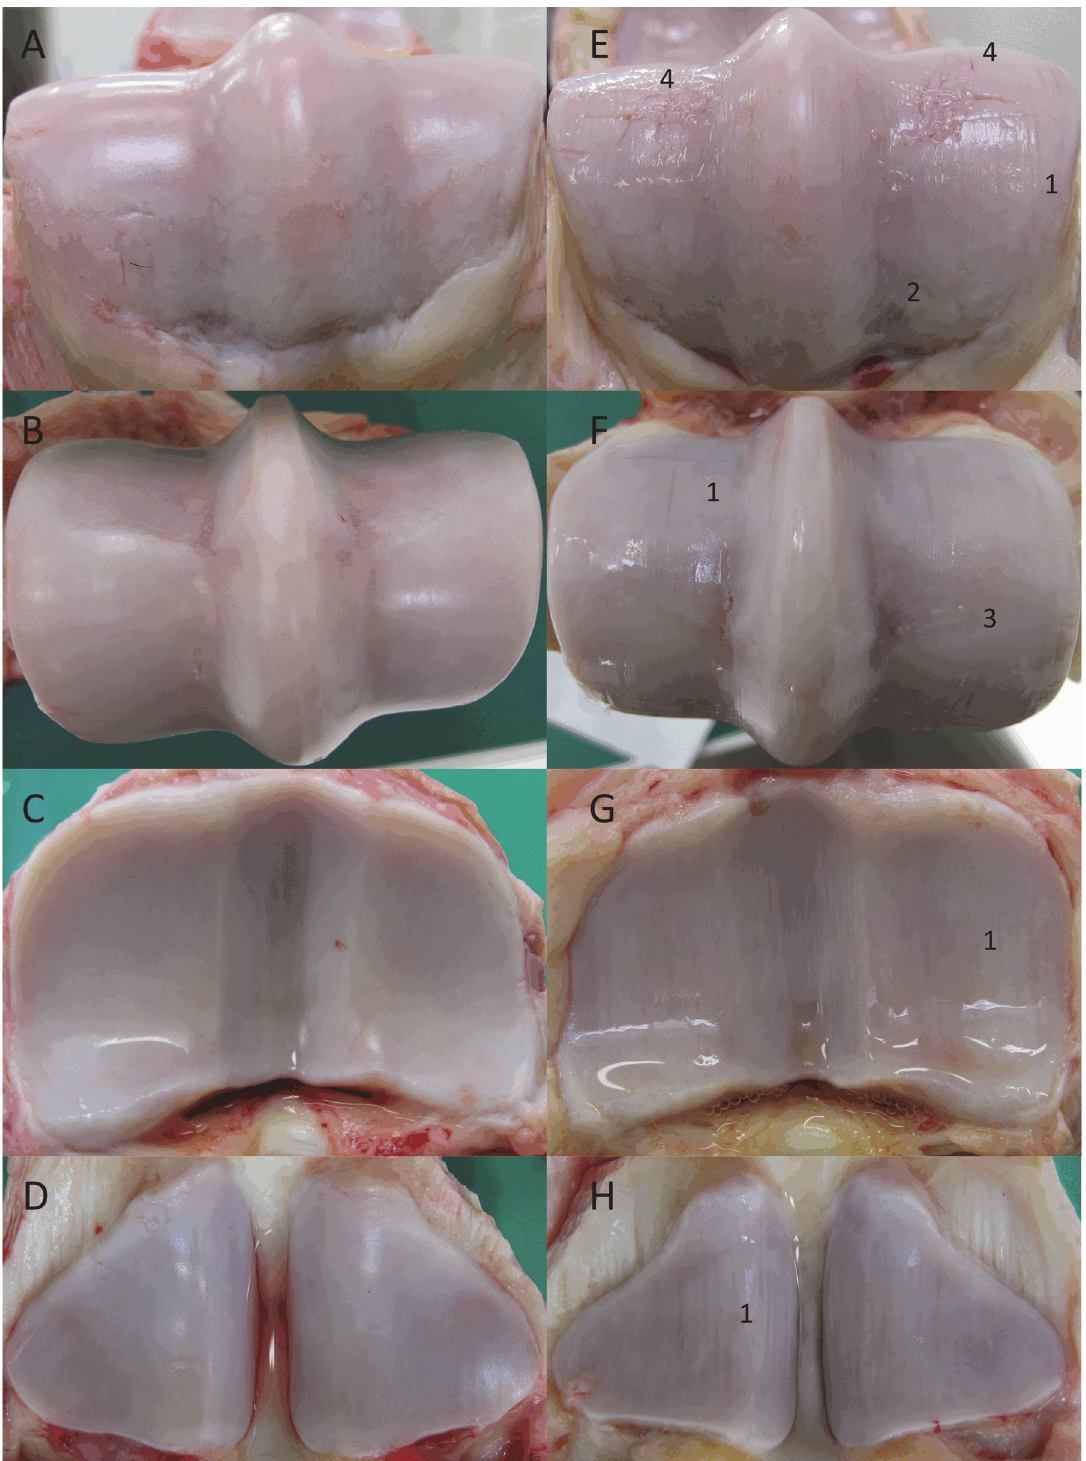
Figure 4. Macroscopic view of the articular cartilage surfaces at week 10 of the sham joints (left) and groove joints (right). (A), (E) are the dorsal aspects of MC3; (B), (F) are the palmar aspects of MC3; (C), (G) are P1; and (D), (H) are PSB. Characteristic grade 2 wear lines (1), grade 3 erosions (2), grade 3 palmar arthrosis (OC lesions of the distal palmar aspect of MC3) (3), and surgical grooves (4).